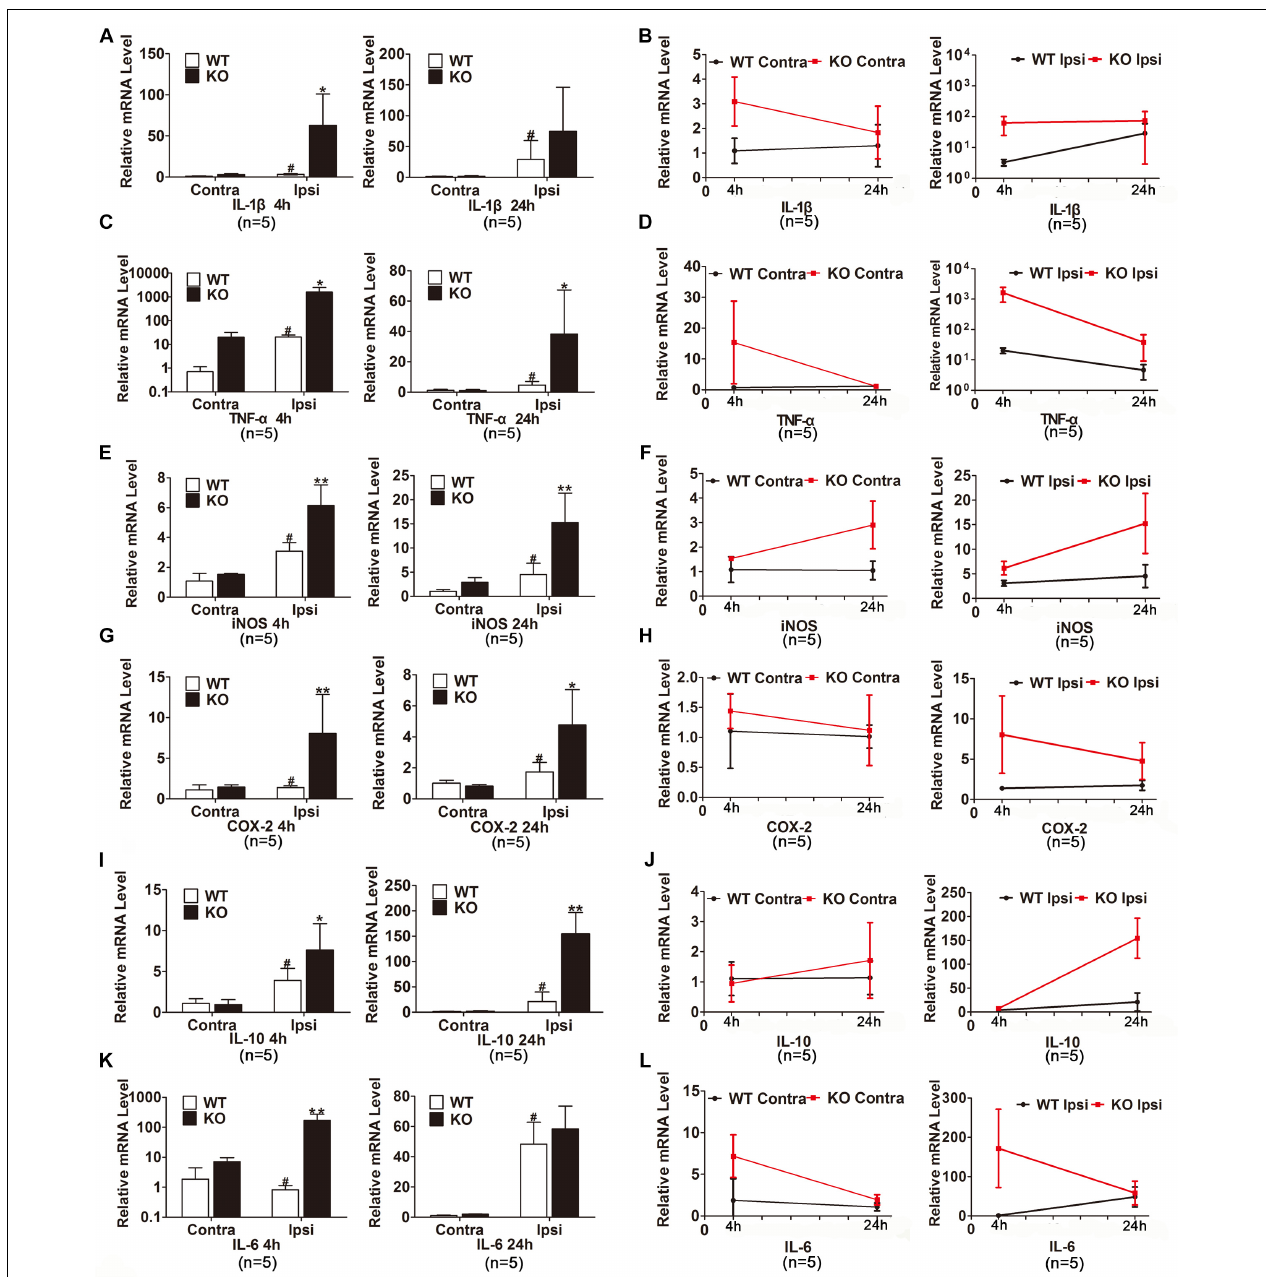
FIGURE 6 | IRAK-M deletion further enhanced the mRNA levels of ischemia-induced inflammatory cytokines in mouse brains. (A – L) Bar charts and linear graphs showing the mRNA levels of IL-1 β (A,B) , TNF- α (C,D) , iNOS (E,F) , COX-2 (G,H), IL-10 (I,J), and IL-6 (K,L) in brain tissues at 4 h and 24 h after reperfusion in WT and KO mice. n = 5 per group. ∗ P < 0.05, ∗∗ P < 0.01 vs. WT group, # P < 0.05 vs. sham